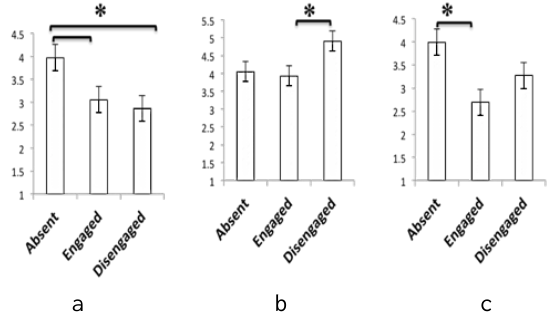
Figure 6. Main effects of social contexts: the bias of individual sensitivity: (a) musician 1 in concert style, (b,c) musician 2 and 3 in emphatic